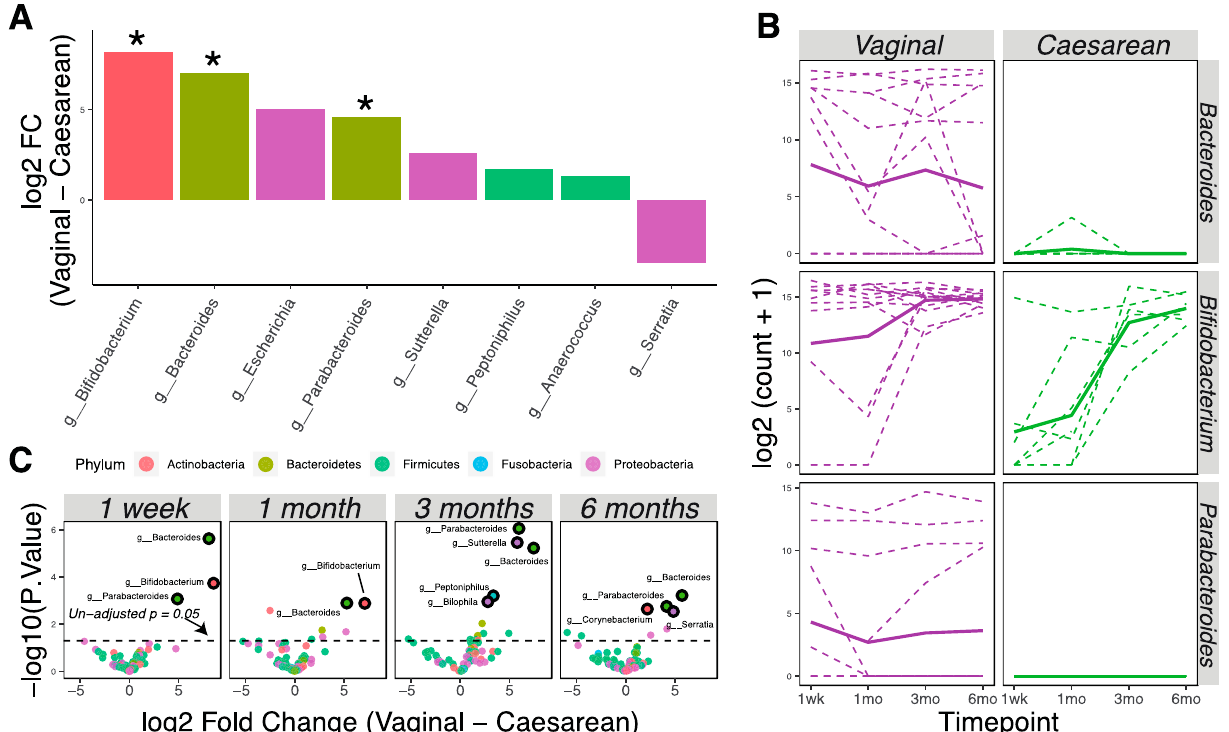
Figure 2. Delivery methods affect the infant microbiota through six months of age. ( A ) Bacterial taxa that were differentially abundant as detected by the limma–voom regression method ( p < 0.05; * adjusted p < 0.05). Taxa with positive numbers are more abundant in vaginally delivered infants; taxa with negative numbers are more abundant in cesarean-delivered infants. Taxa were colored according to phylum membership. ( B ) Representation of significantly changed taxa at each time point in vaginally delivered vs. cesarean-delivered infants. Solid lines show the mean abundance; dashed lines show the individual level. ( C ) Volcano plots show significantly different taxa between vaginally delivered and cesarean-delivered infants at different time points. Markers for taxa having significant adjusted p values (<0.05) are circled in black.